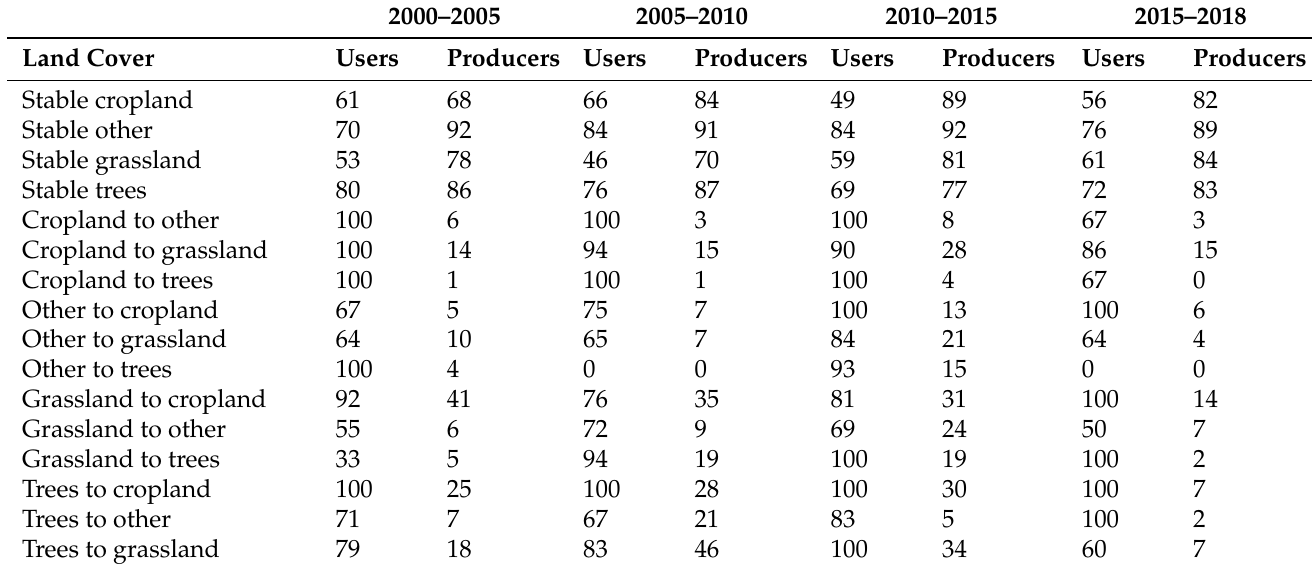
Table 4. User’s and producer’s accuracy (%) for four different time periods assessed in this